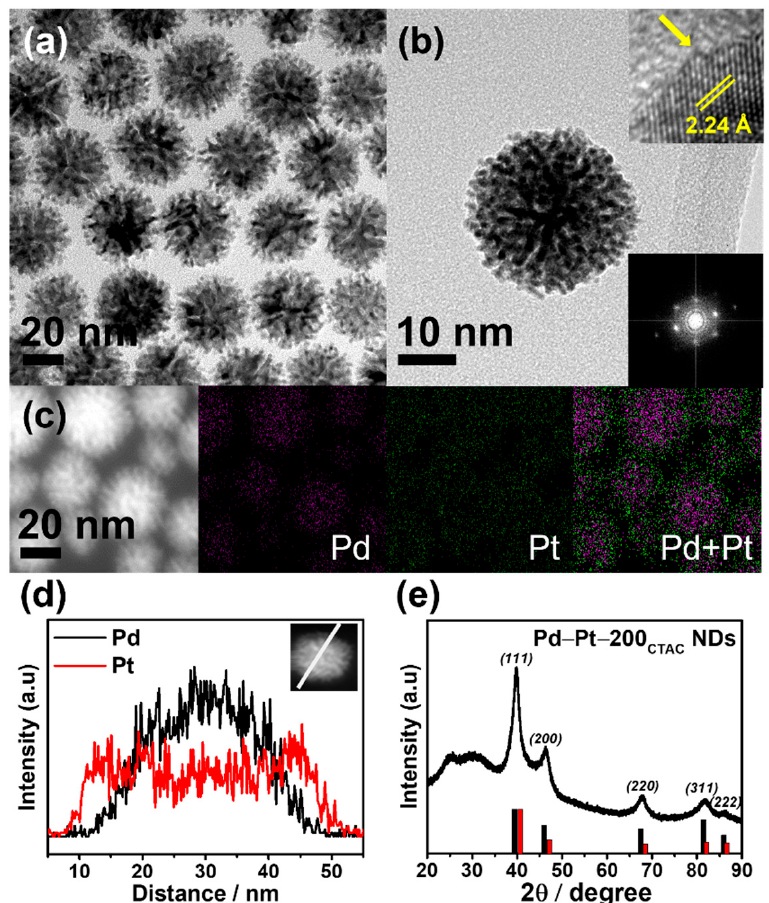
Figure 1. ( a , b ) HR–TEM image including the correspond FFT images. HAADF-STEM image with ( c ) corresponding EDS elemental mapping images, and ( d ) line-scan profile analysis of Pd (black) and Pt (red) for the Pd–Pt NDs. ( e ) XRD pattern confirm of corroborating the Pd–Pt bimetallic feature.